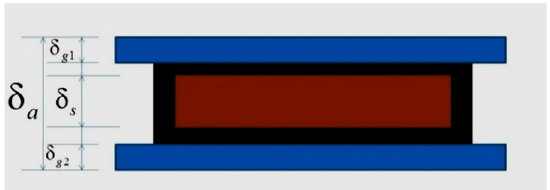
Figure 8. Schematic of asphalt film thickness measurement.